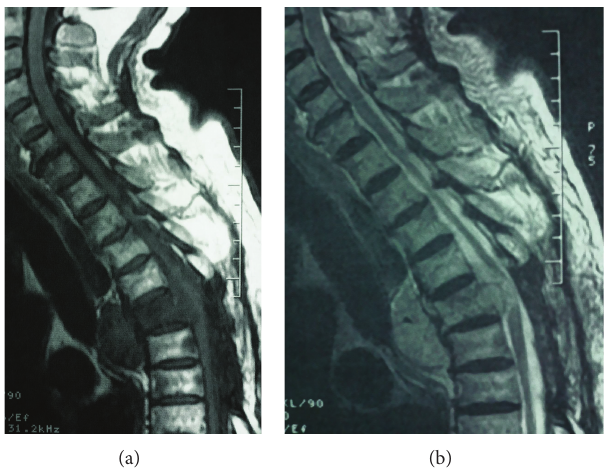
Figure 6: Recurrence sagittal T1-weighted (a) and T2-weighted (b) MR images showing an important space occupying mass with spinal cord compression, T5 vertebral body involvement, and large posterior medastinum